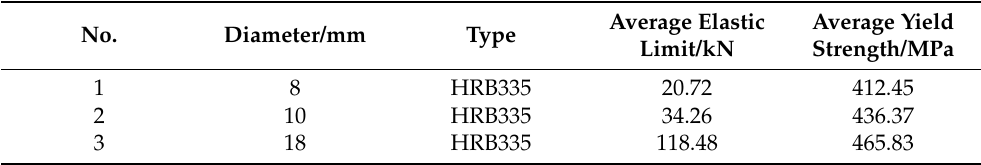
Table 5. Properties of steel bars.